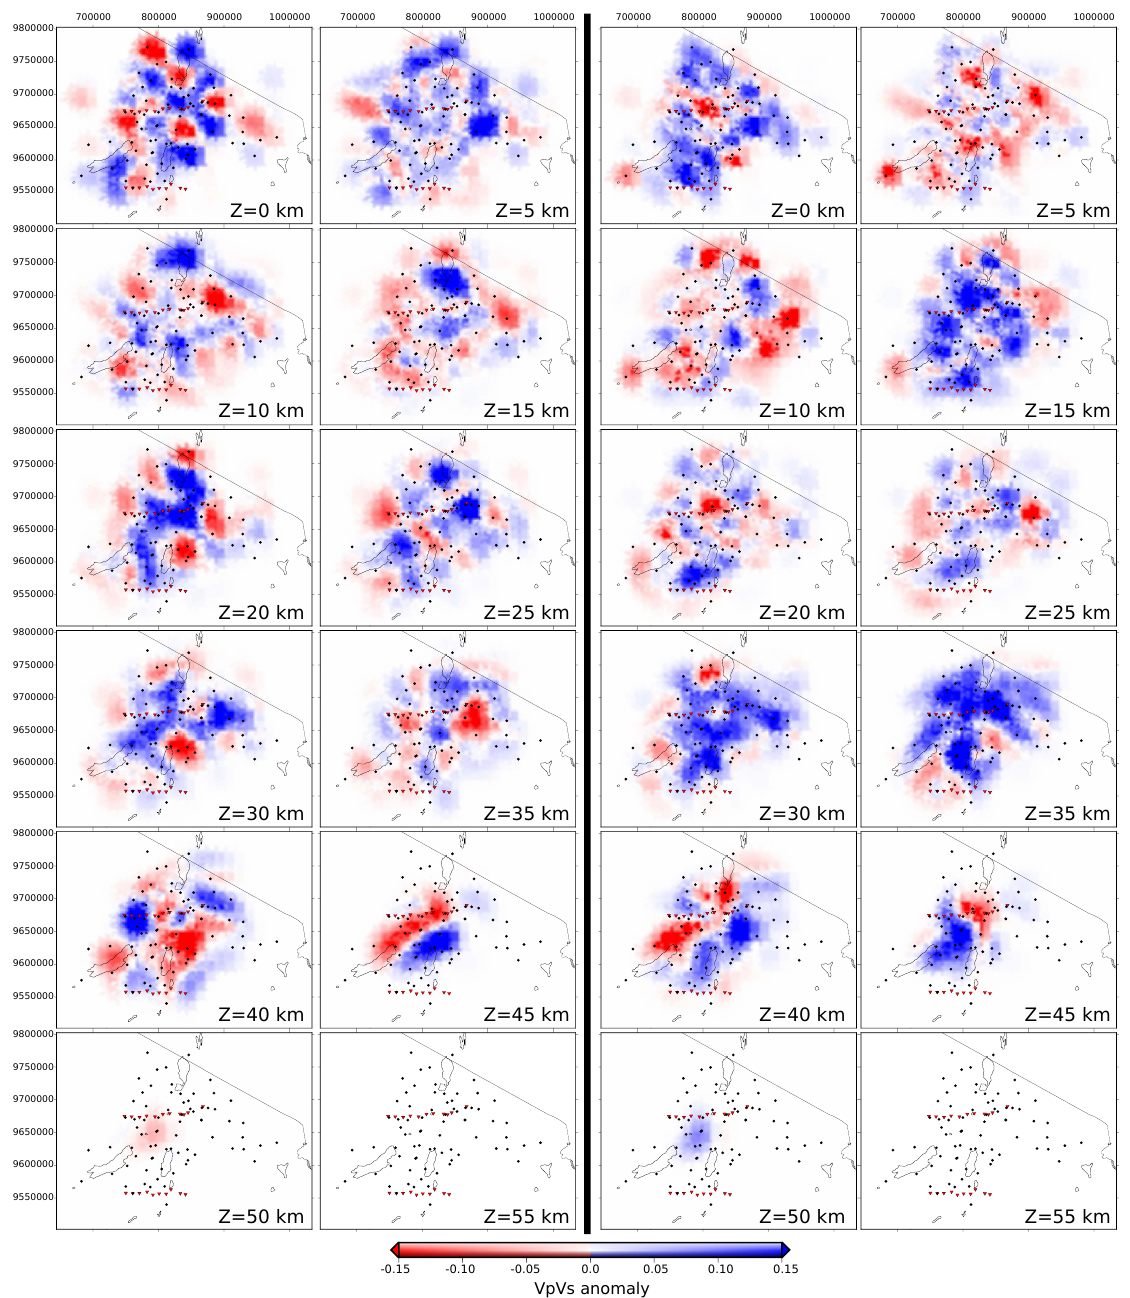
Figure A11. On the left: Vp/Vs ratio checkerboard test model computed from P- and S-wave velocity model in Figure 3. On the right: Vp/Vs ratio checkerboard test model computed with smaller anomalies. The white color indicates zones not constrained by seismic rays. See text for more